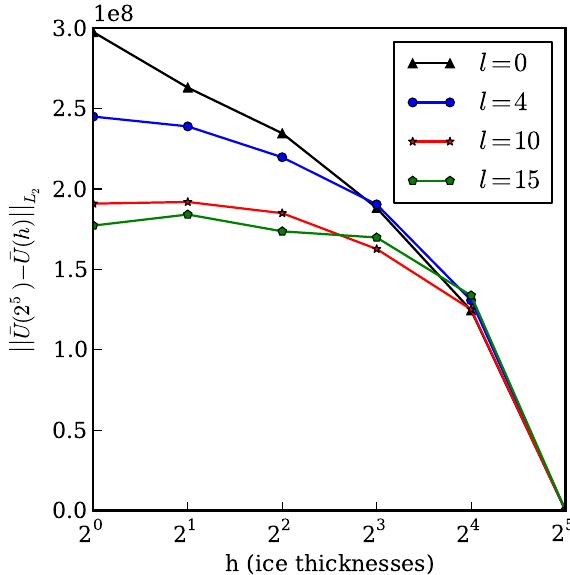
Figure 1. Residual between balance velocity solution at coarse and progressively finer length scales for l ∈ { 0 , 4 , 10 , 15 }